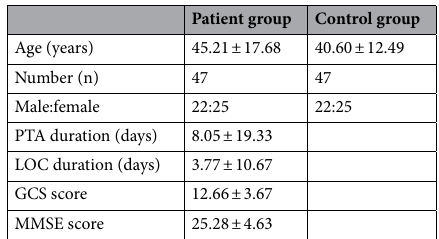
Table 1. Demographic data for the patient and control groups. PTA post-traumatic amnesia, LOC loss of consciousness, GCS Glasgow coma scale, MMSE mini-mental state examination; Values are means ± standard